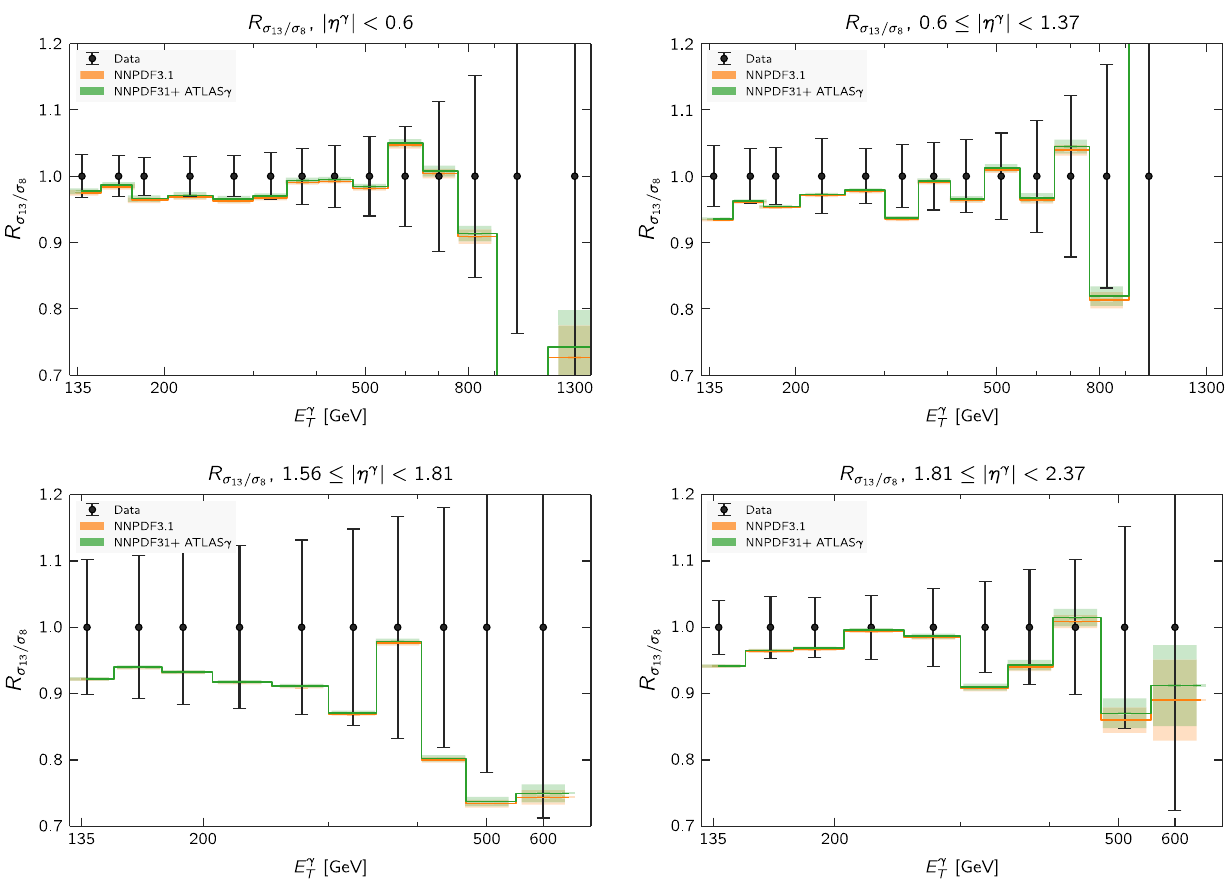
γ ,η γ ) ratio and the corresponding theoretical calculations using T